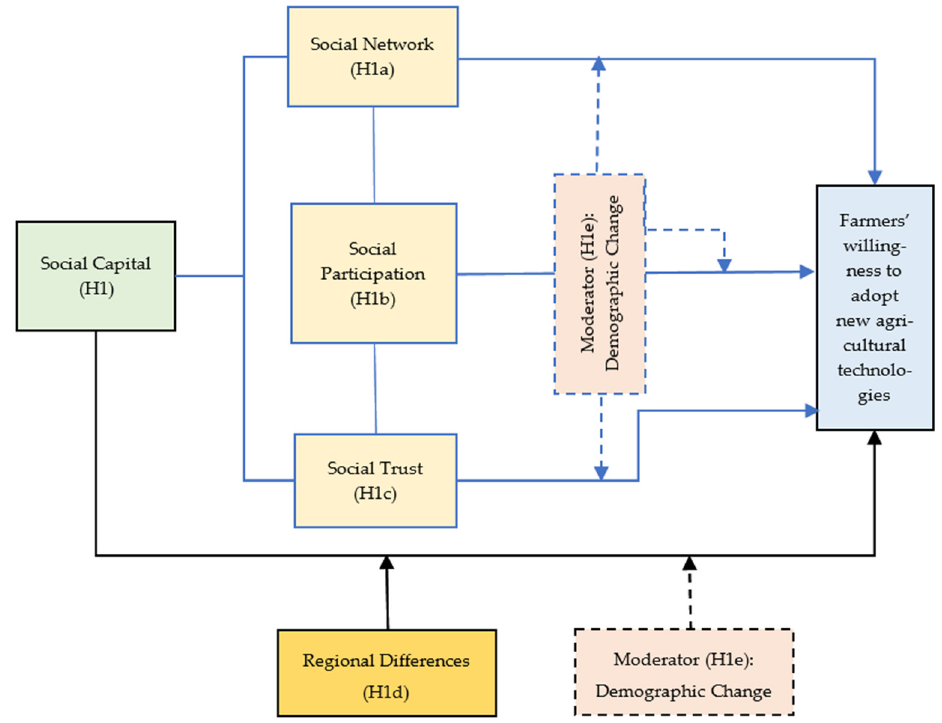
Figure 1. Theoretical analysis framework.